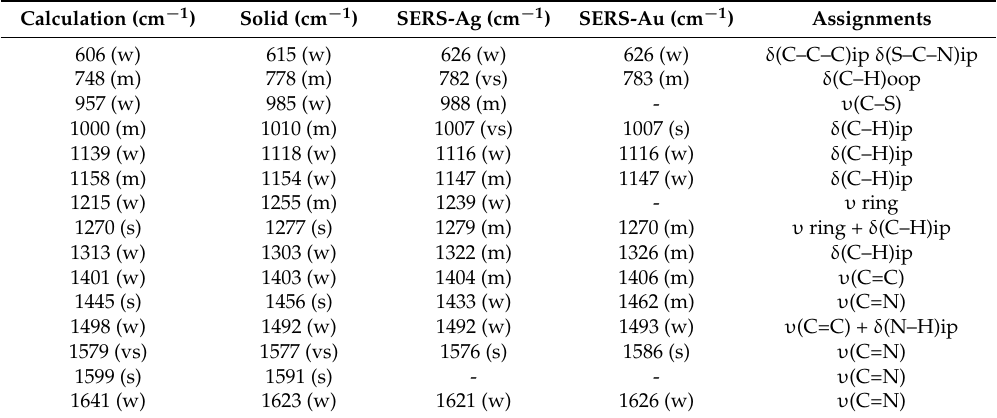
Table 1. The proposed assignment of Raman bands of